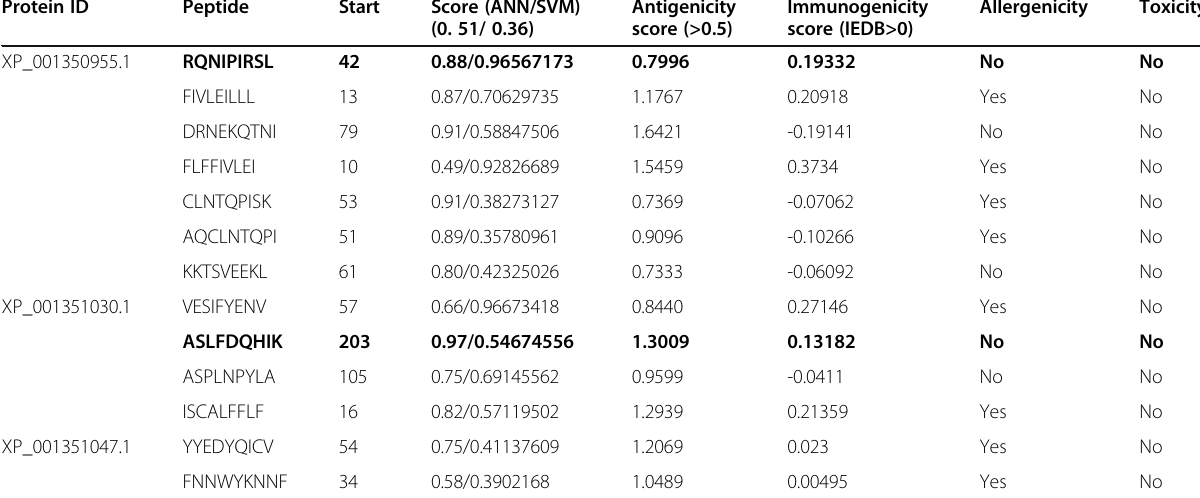
Table 5 List of cytotoxic T cell epitopes predicted from the three hypothetical proteins of Plasmodium falciparum Protein